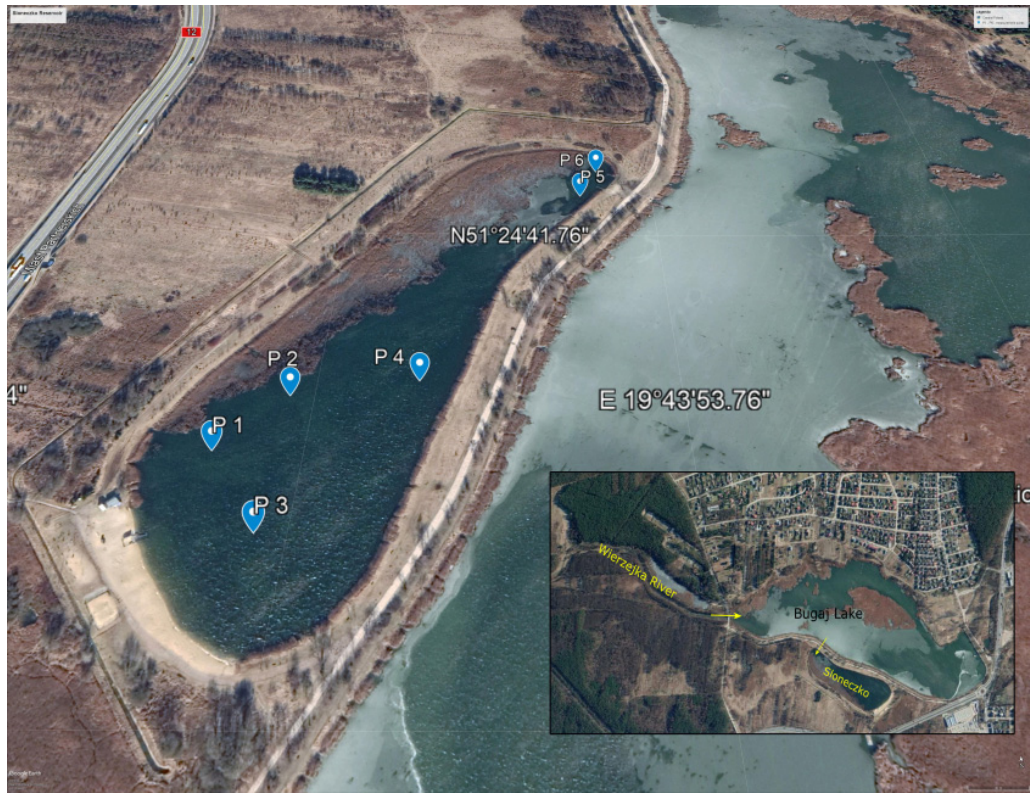
Figure 1. Map of the measurements points at S ł oneczko Reservoir. Table 1. Morphometric characteristics of the reservoir.